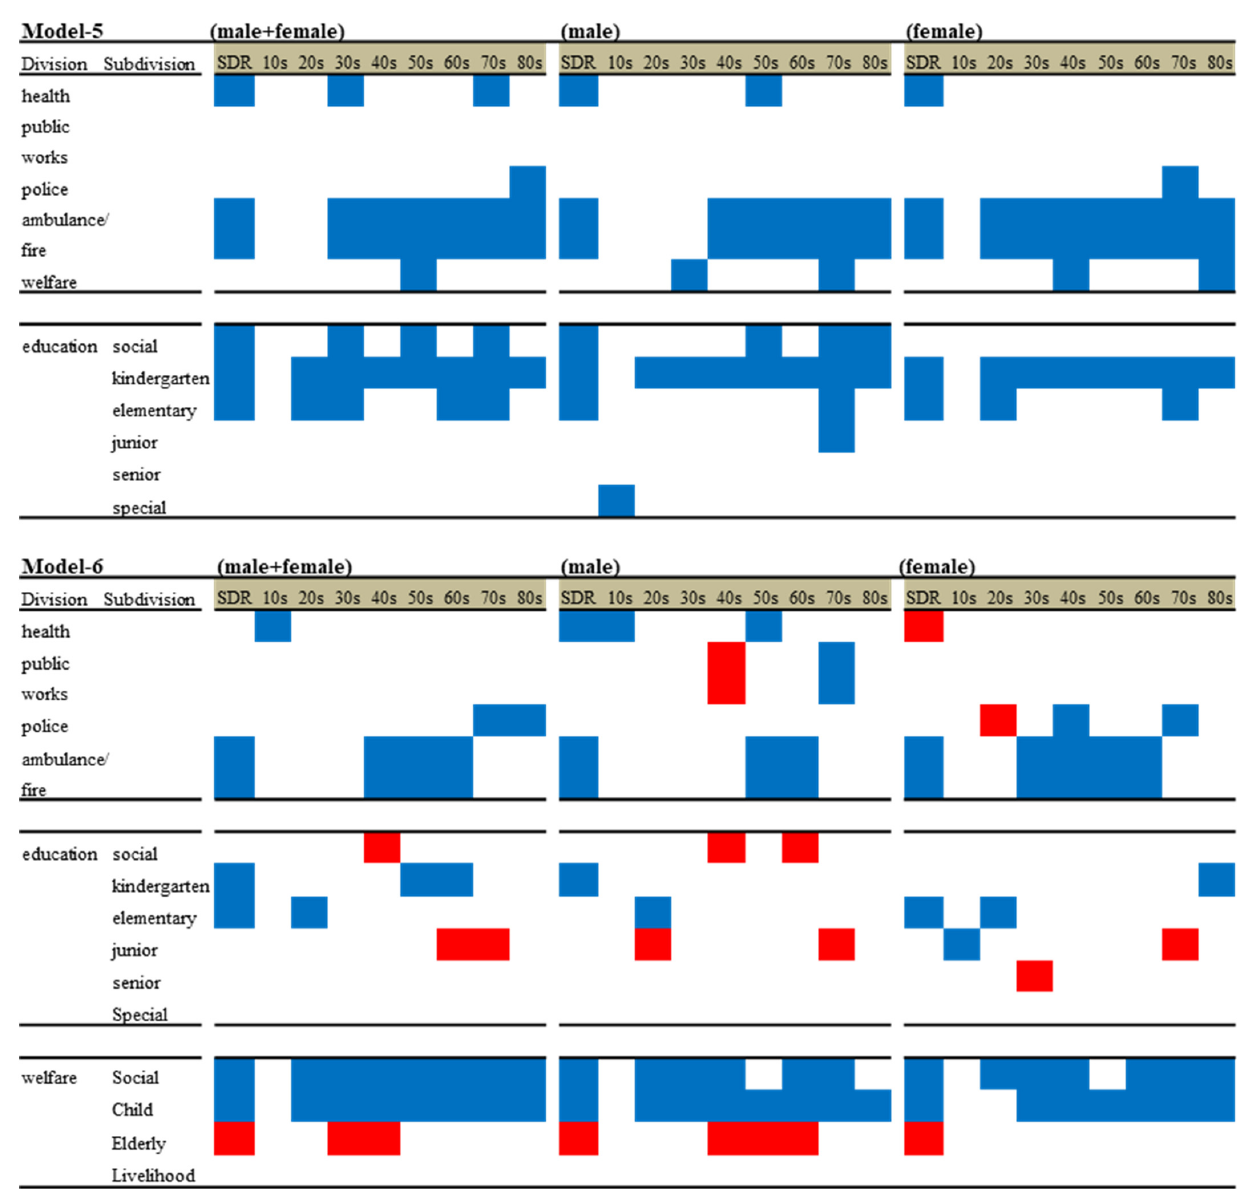
Figure 6. Summary of effects of regional financial expenditure of divisions and subdivisions of education (Model 5) and welfare (Model 6) on suicide mortality of males and females together (M + F), males (M) and females (F) from 2009 to 2018. Blue and red columns, significant factors for decreasing and increasing suicide mortality, respectively.